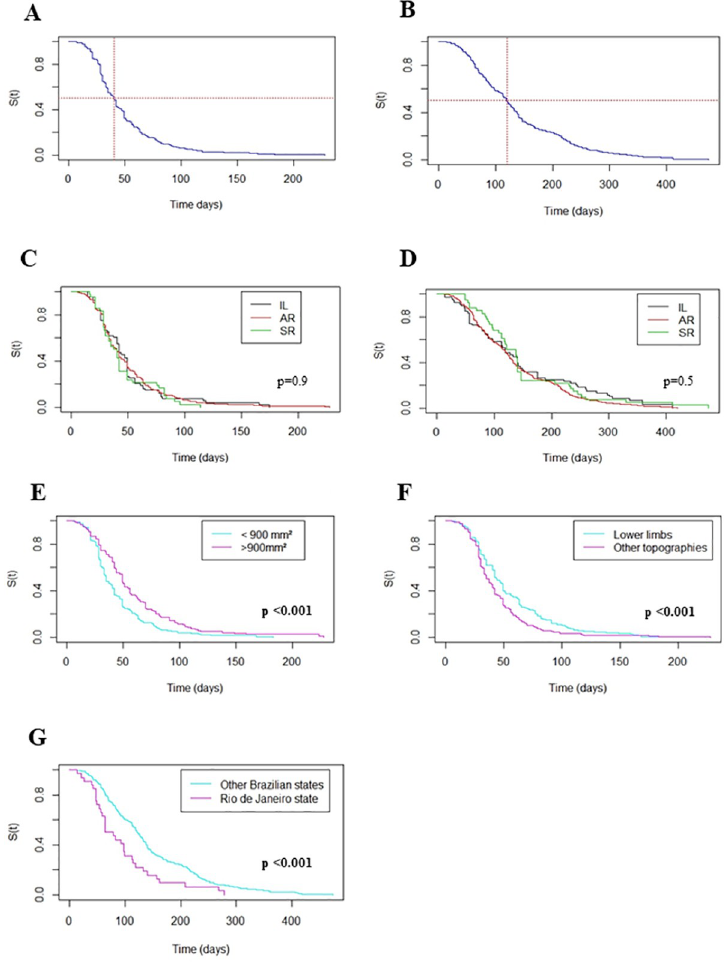
Fig 5. Kaplan-Meier curves of the analyzed groups and epithelialization / complete healing of cutaneous leishmaniasis lesions. A) Epithelialization of cutaneous lesions; B) Complete healing of cutaneous lesions; C) Epithelialization of lesions according to the groups; D) Complete healing according to the groups; E) Epithelialization according to lesion´s area; F) Epithelialization according to lesion topography; G) Complete healing according to likely location of infection. SR—standard regimen; AR—alternative regimen; IL—intralesional route; S(t)- Survival function. Bold: p-value < 0.05 (according to Log-Rank test).